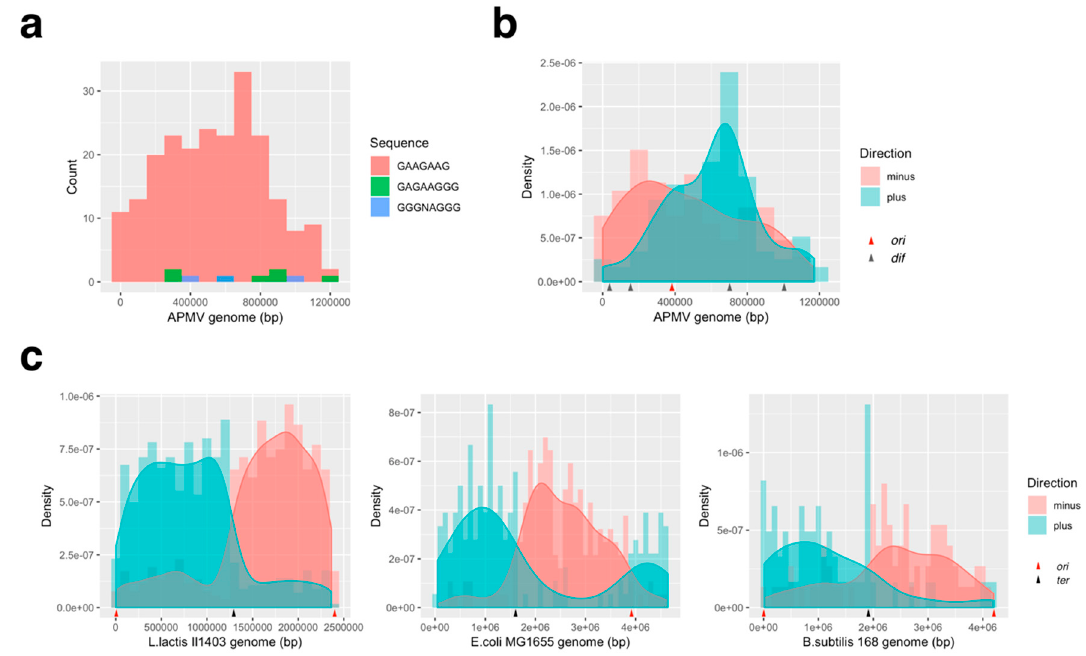
Figure 10. Bacterial KOPS distribution on APMV. ( a ) Frequency distribution of bacterial KOPS distribution in the APMV genome (AY653733.1, L. lactis ; 5 ′ -GAAGAAG-3 ′ , B. subtilis : 5 ′ -GAGAAGGG-3 ′ , E. coli : 5 ′ -GGGNAGGG-3 ′ ). Complementary sequences were also counted. ( b ) Density graph of the L. lactis type KOPS in the APMV genome (AY653733.1). KOPS on the positive and negative strand of the APMV genome were plotted separately. Red arrow: estimated ori region; dark gray arrows: dif sequence positions ( c ) Bacterial KOPS distributions in bacterial genomes ( L. lactis Il1403: NC_002662.1, E. coli MG1655: NC_000913.3, B. subtilis 168: NC_000964.3). Red and black arrows indicate the ori and ter positions, respectively.